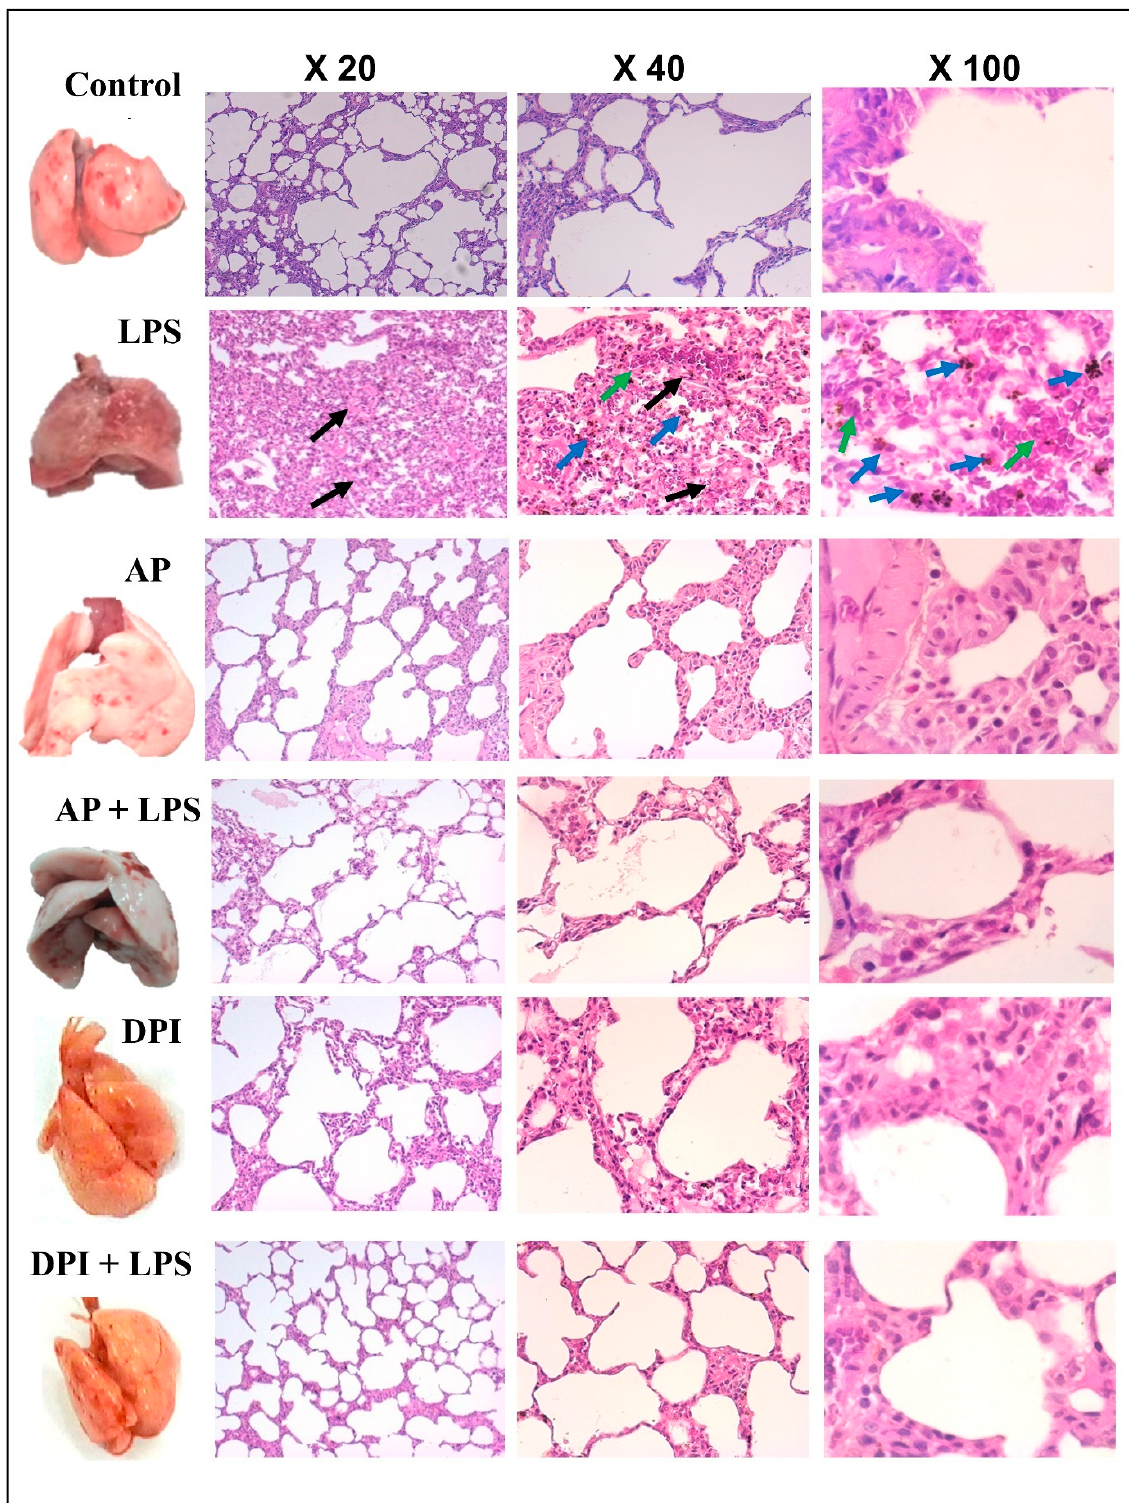
Figure 3. Morphological and histological evaluation of the lungs in different groups: Images of different magnifications are displayed. Blue: erythrocyte aggregation; green: intense neutrophil; black: pulmonary edema. For each condition image of one rat lung is representative of five rats.